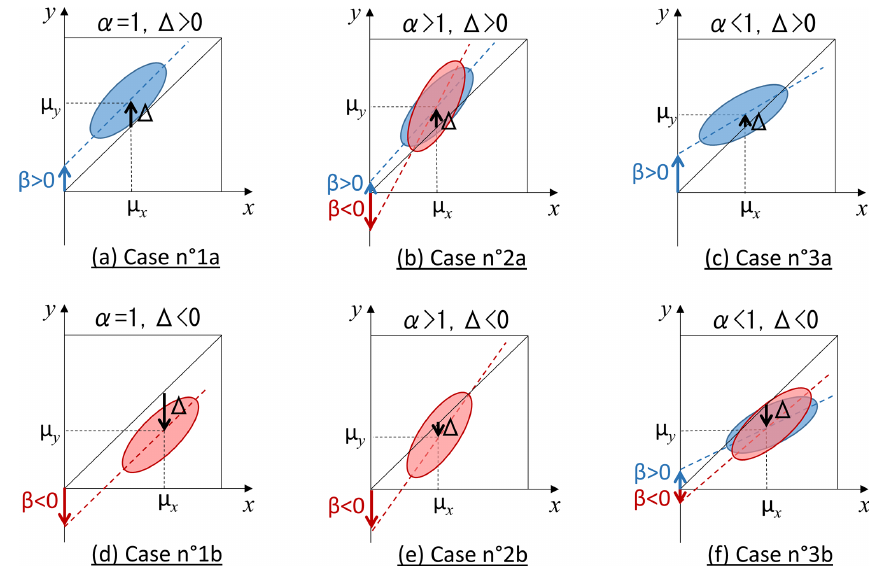
Figure B1. Illustration of different cases of paired observations with perfect scaling ( α = 1 ) , imperfect scaling ( α > 1 or α < 1), and positive or negative bias ( (cid:49) > 0 or (cid:49) < 0). Each case has a different implication on the offset parameter β obtained from a linear regression with the model y = αx + β . The regression lines are shown as dashed lines, with red indicating negative offsets and blue positive offsets. The 1 : 1 lines are shown as solid black lines. The distributions of data around the regression lines are represented schematically by the red and blue